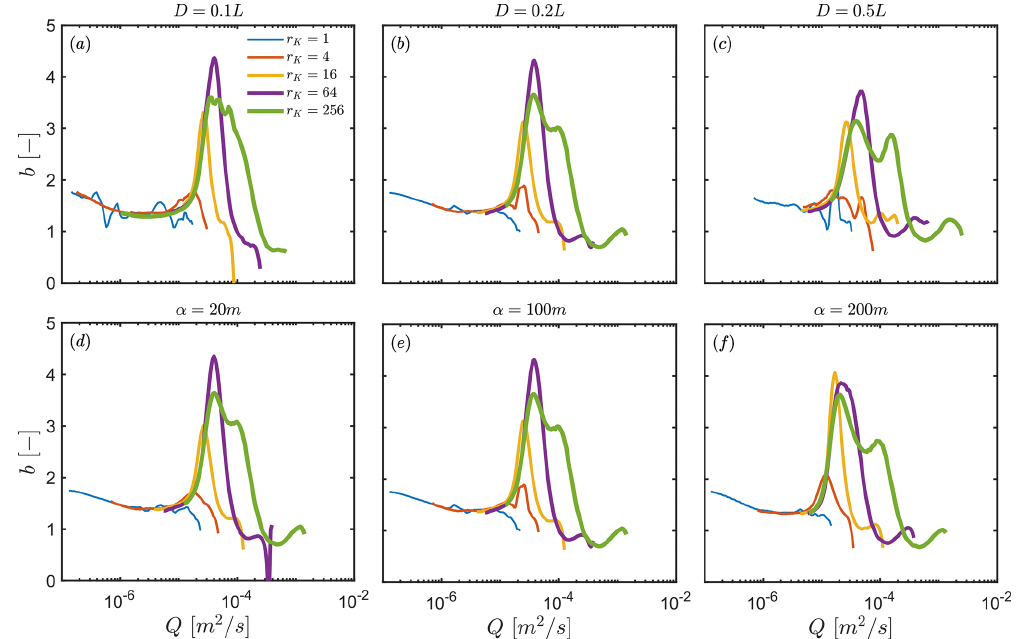
Figure 7. Evolution of local b values as a function of discharge Q for the range of hydraulic conductivity ratios r K and different upper compartment thickness D (a–c) and characteristic length of permeability and porosity decrease with depth α (d–f) . β is fixed at a value of